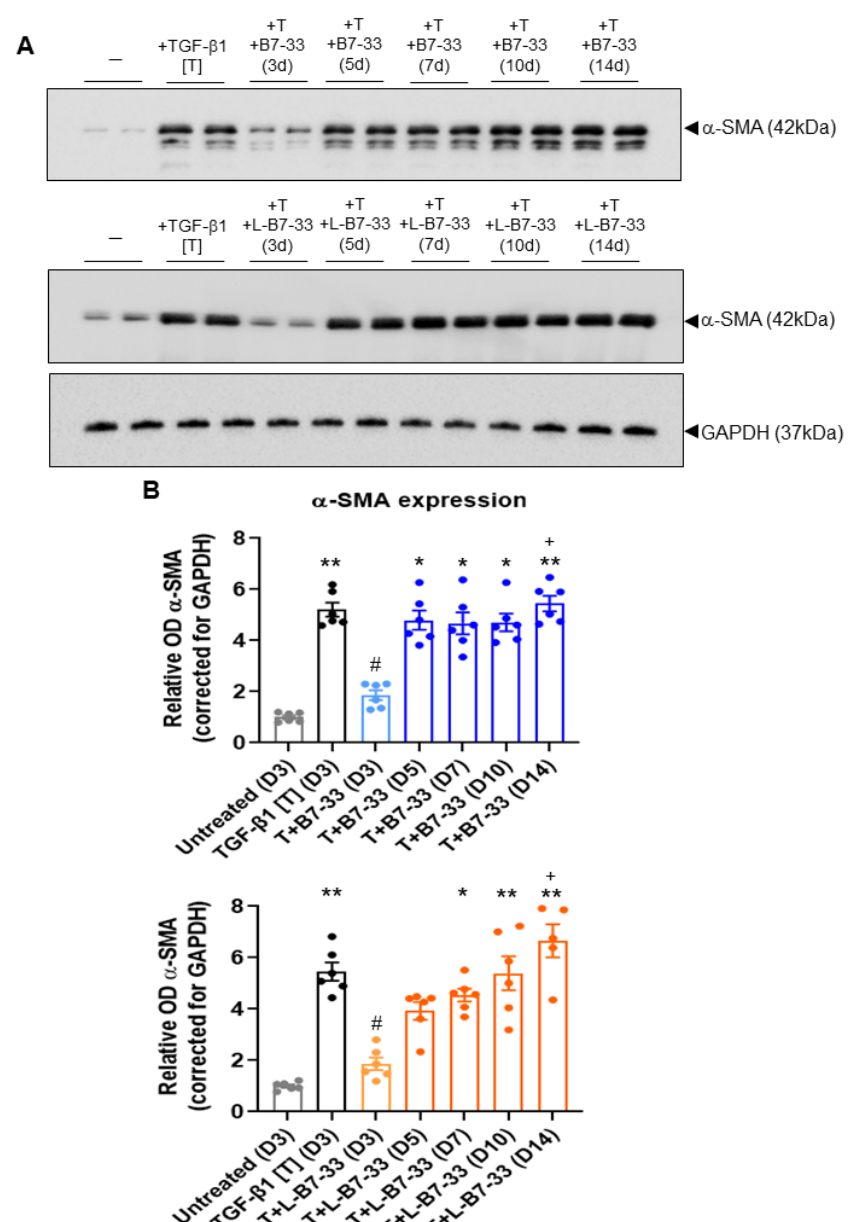
Figure 6. The effects of B7-33 vs. L-B7-33 on myofibroblast differentiation in vitro. ( A ) Representative Western blots of α -SMA expression and corresponding GAPDH expression from unstimulated BJ3 human dermal fibroblasts, TGF- β 1 (T)-stimulated BJ3 human dermal myofibroblasts and T + B7-33- or T + L-B7-33-treated myofibroblasts after 3 days (D3); and T + B7-33- or T + L-B7-33-treated myofibroblasts after 5 days (D5), 7 days (D7), 10 days (D10) or 14 days (D14). ( B ) Also shown are the mean ± SEM levels of a-SMA expression from each treatment group, corrected for GAPDH loading and expressed relative to the unstimulated cell control group, which was expressed as 1 in each case; from n = 6 separate experiments conducted in duplicate. Statistical analysis: p < 0.05, * p < 0.01 vs. untreated (D3) group; # p < 0.05 vs. TGF- b1 [T] (D3) group; + p < 0.05 vs. T+B7-33 or T+L-B7-33 (D3) group, as determined using a non-parametric Kruskal Wallis test and Dunn’s post-hoc analysis to allow for multiple comparisons between the